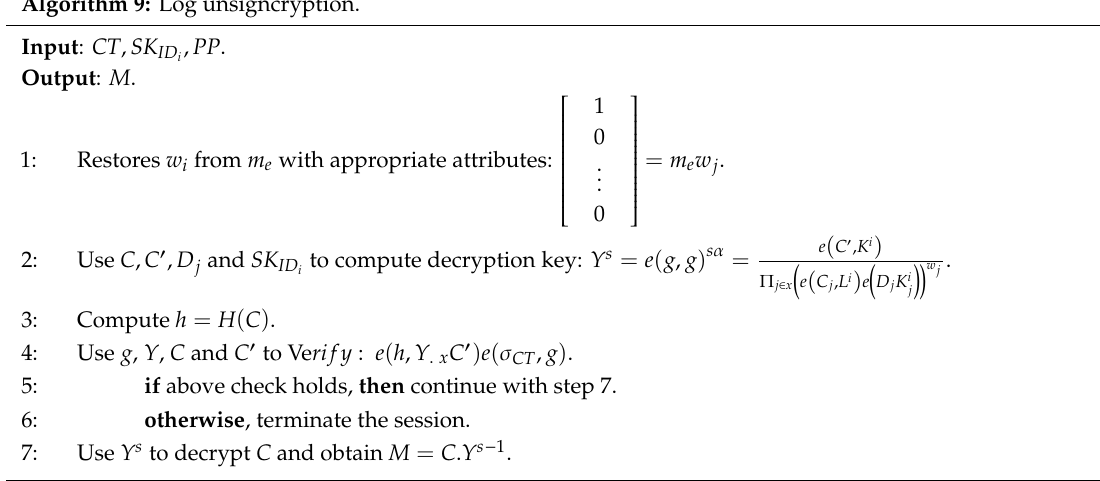
Algorithm 9: Log